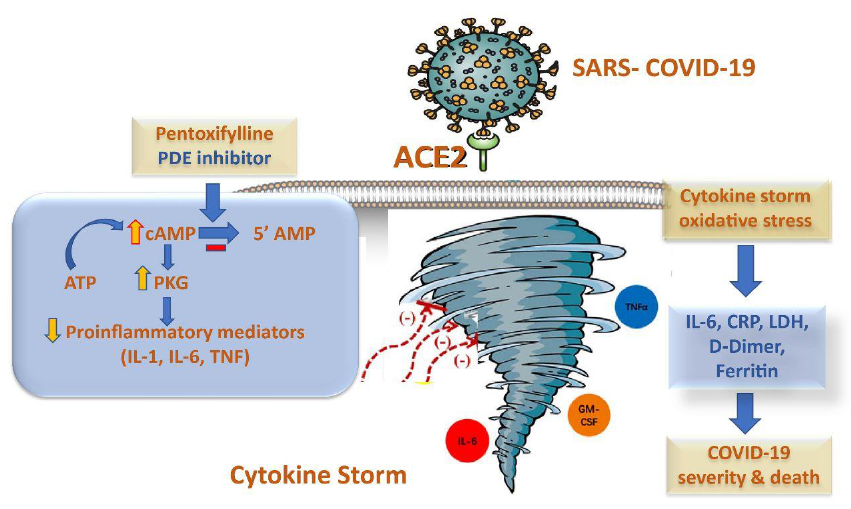
Figure 1. The potential anti-inflammatory mechanism of pentoxifylline in cytokine storm syndrome in COVID-19 patients.